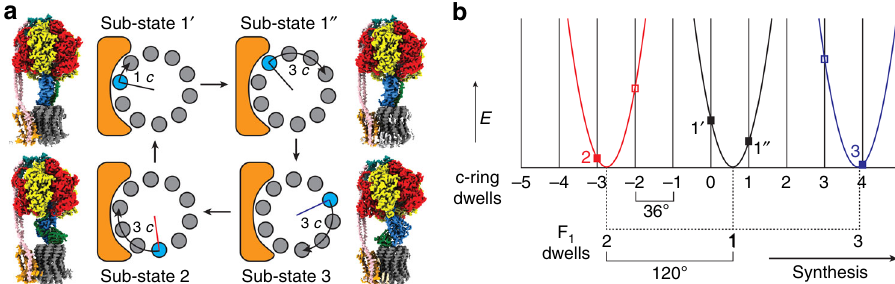
Fig. 3 The F o motor is observed in four discrete rotational positions. a Simple schematic to describe c-ring positions observed in this study. Arrows show rotation of the c-ring between each step in the ATP synthesis direction (same c subunit colored in cyan and all others in gray) with colored radii (black in Sub-state 1 ’ and 1 ” , blue in Sub-state 3 and red in Sub-state 2) describing relative position to the subunit a colored orange (see Supplementary Fig. 6 for assignment of the rotational position of the c-ring). Each schematic is accompanied by a cryo-EM map representative for the state discussed. Sub-state 1 ’